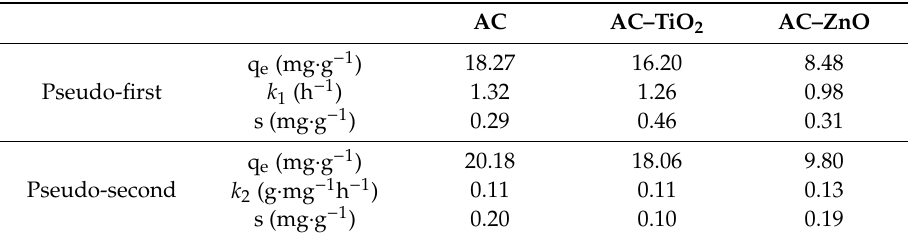
Table 3. Kinetic parameters of the model PFO and